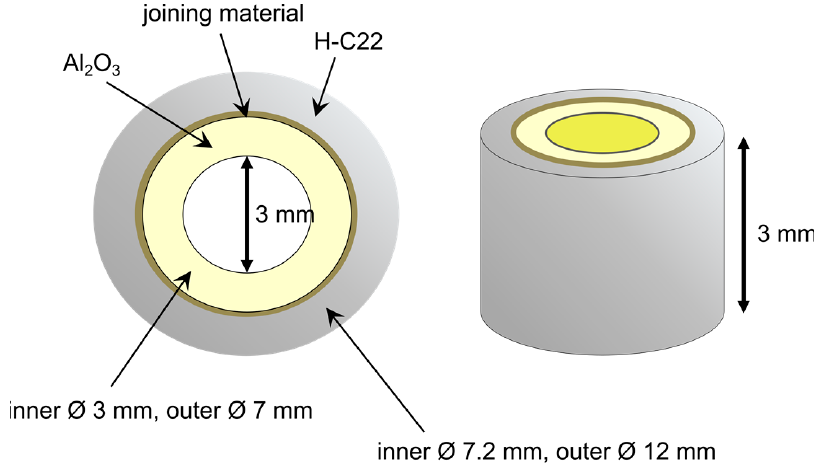
Figure 1. Schematic of the joining configuration. All the sample dimensions are reported. Table 1. Range of chemical composition (wt %) of the Hastelloy C22 ® samples.